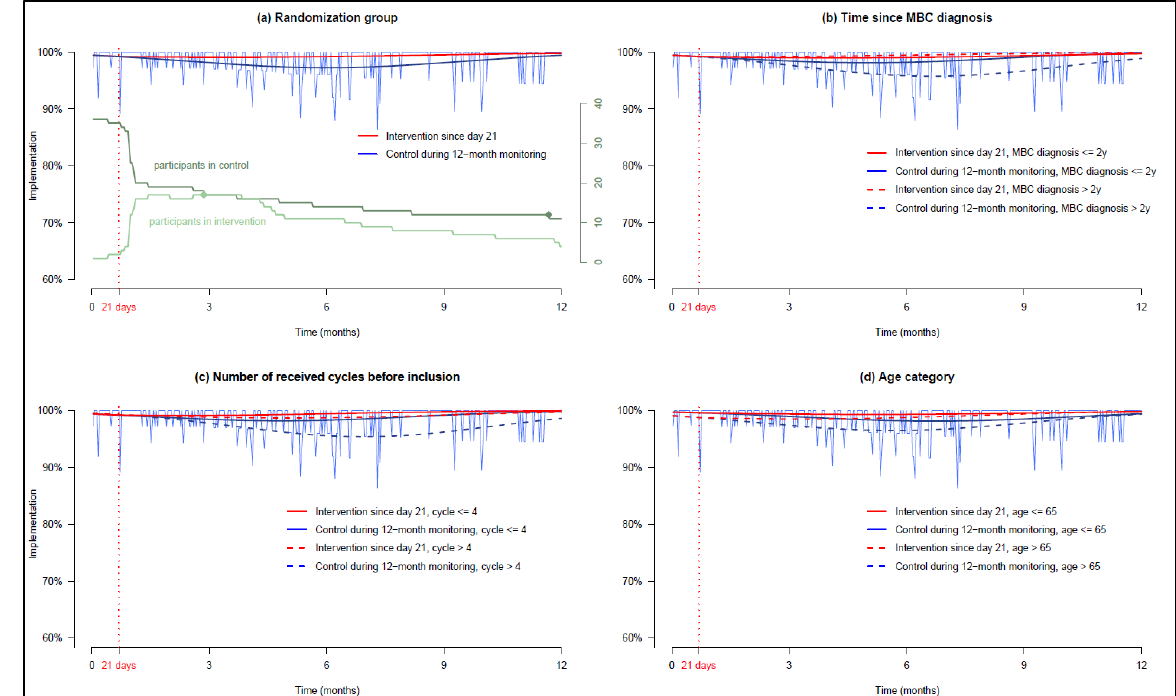
Figure 2. GEE models estimating patient implementation (the vertical red dotted line indicates the randomization at day 21, date on which the intervention starts—i.e., after the baseline period). ( a ) Patients’ palbociclib implementation in each randomized group, ( b ) dichotomization in each group according to time since MBC diagnosis, ( c ) dichotomization in each group according to the number of palbociclib cycle received before inclusion, and ( d ) dichotomization in each group according to age. NB: In ( a ), the two discontinuations are represented by dots in the green curves depicting the number of participants over time.